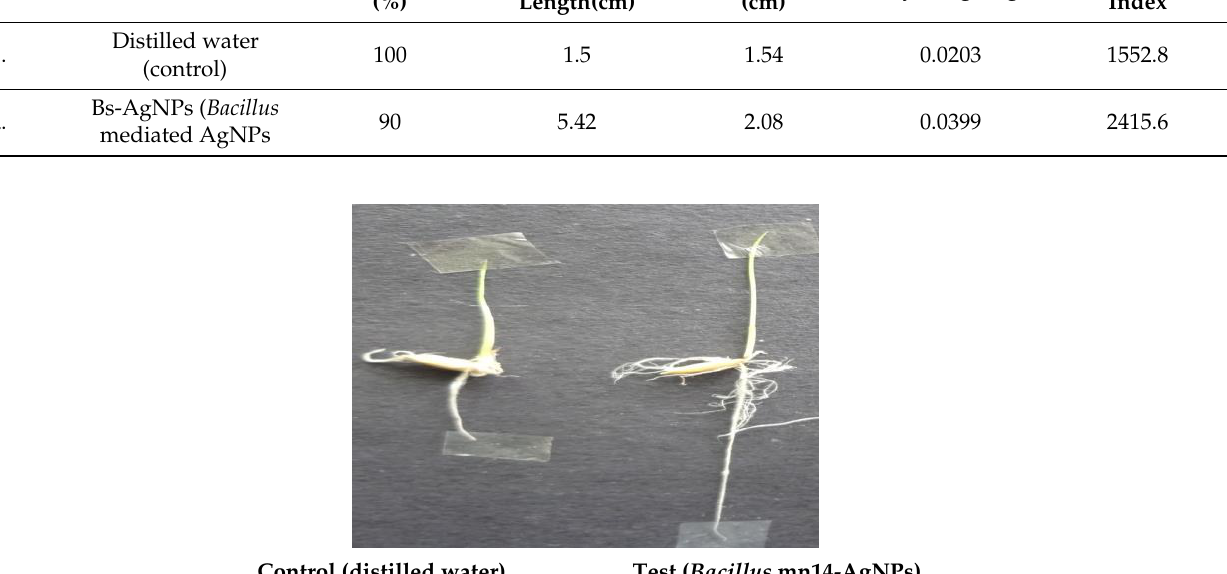
Figure 14. Plant growth